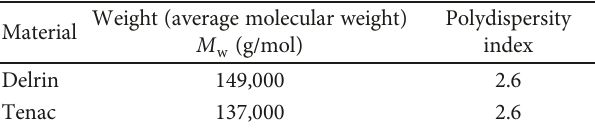
Table 1: Molecular characteristics of the POM resins used in this study.